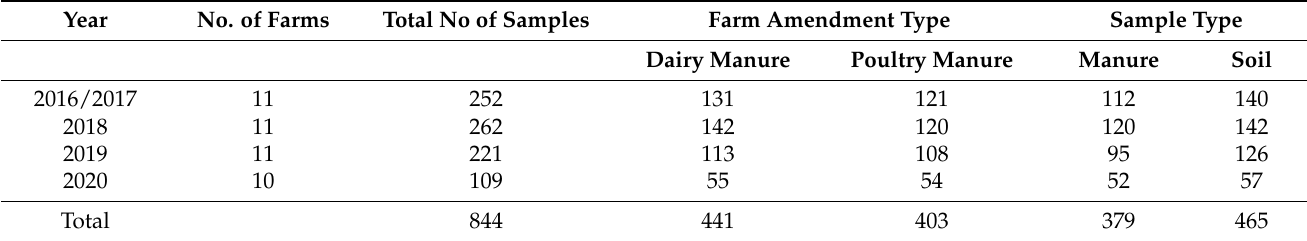
Table 1. Total number of samples collected between October 2016 and October